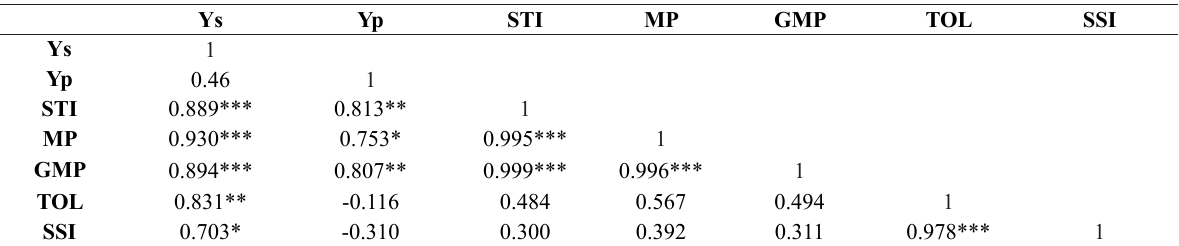
Table 10. Correlations among different drought stress indices and grain yield under irrigated conditions and drought stress conditions or deficit irrigation of the assessment of tolerant wheat genotypes ( Triticum aestivum L.) to drought in conditions of La Molina LM 2019B. Ys Yp